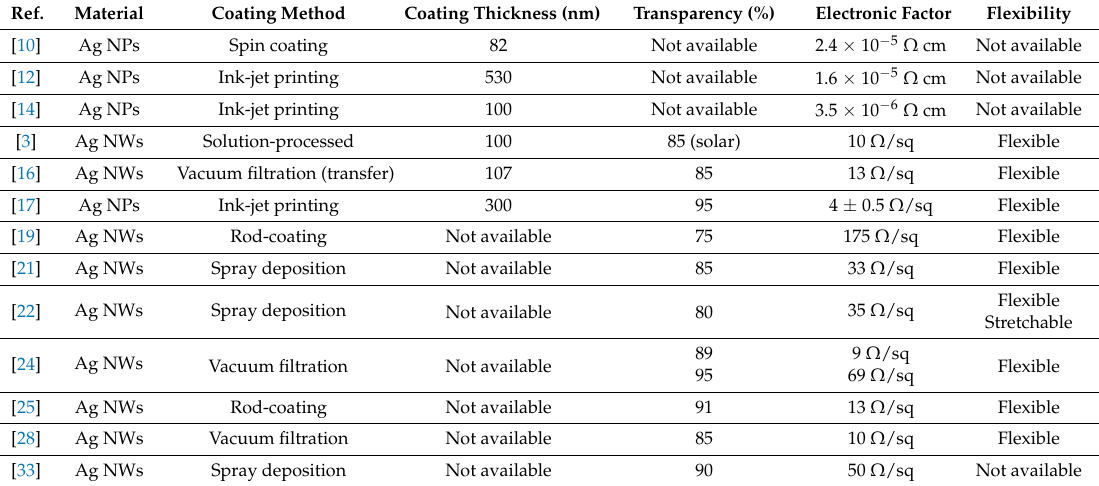
Table 1. Summary of different deposition methods and properties of the Ag NW and Ag NP coatings and thin